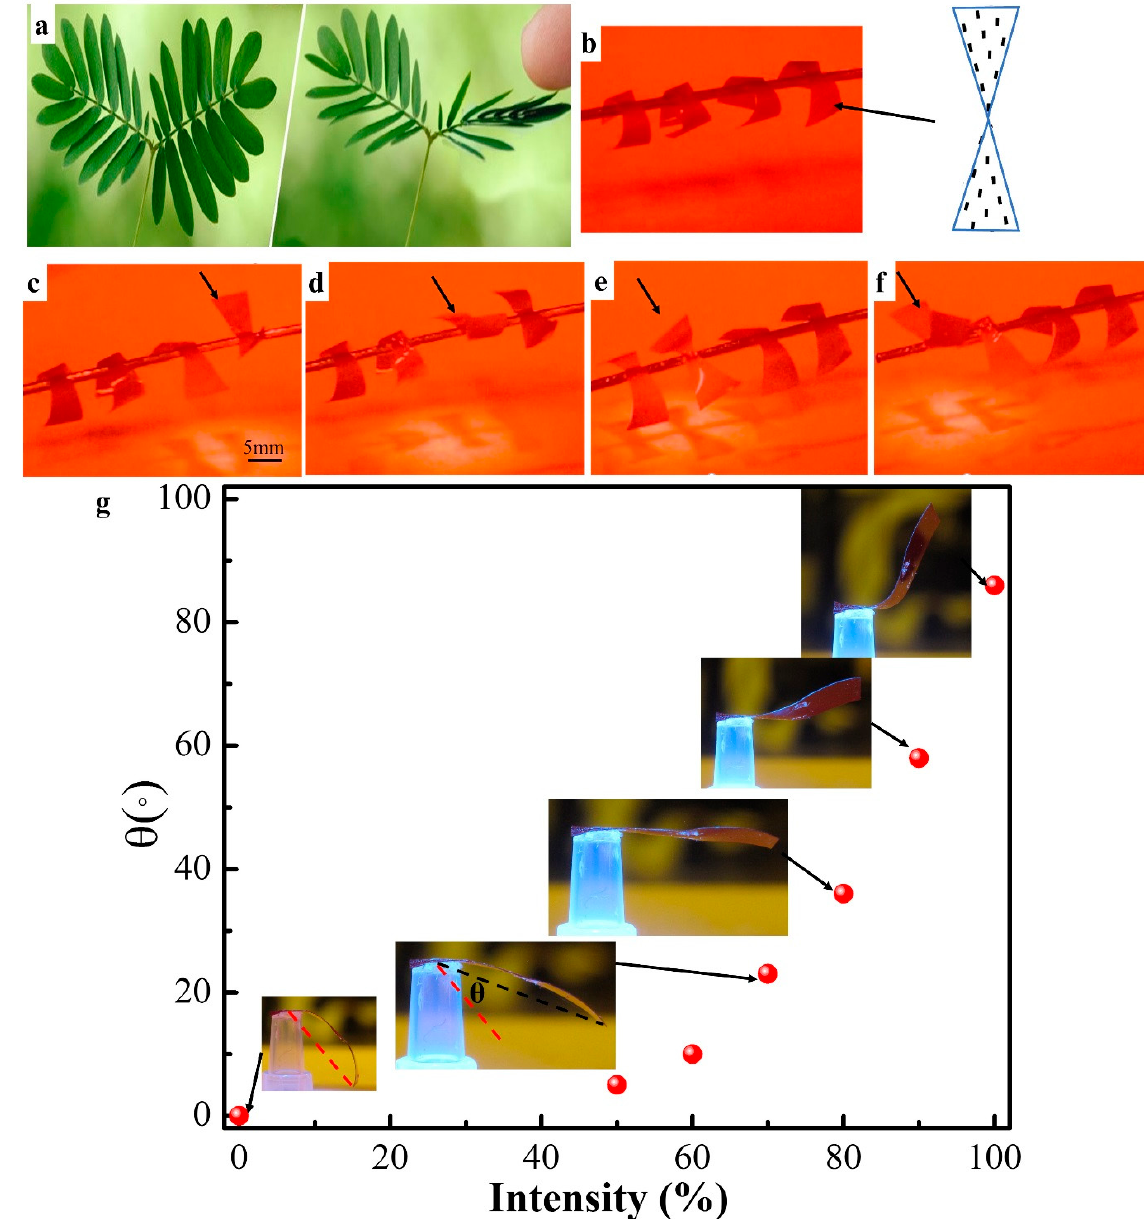
Figure 5. Bioinspired LCE Mimosa Pudica . ( a ) Leaves of plant Mimosa Pudica close immediately when stimulated by external forces. ( b ) The bioinspired LCE Mimosa Pudica before irradiation. The LCE assumes a hybrid configuration with the top surface pattern shown in the inset. ( c – f ) The “leaves” react to an external stimulus, “light”. The black arrow indicates the leaf pairs that are under irradiation. ( g ) The dependence of bending angle θ on light